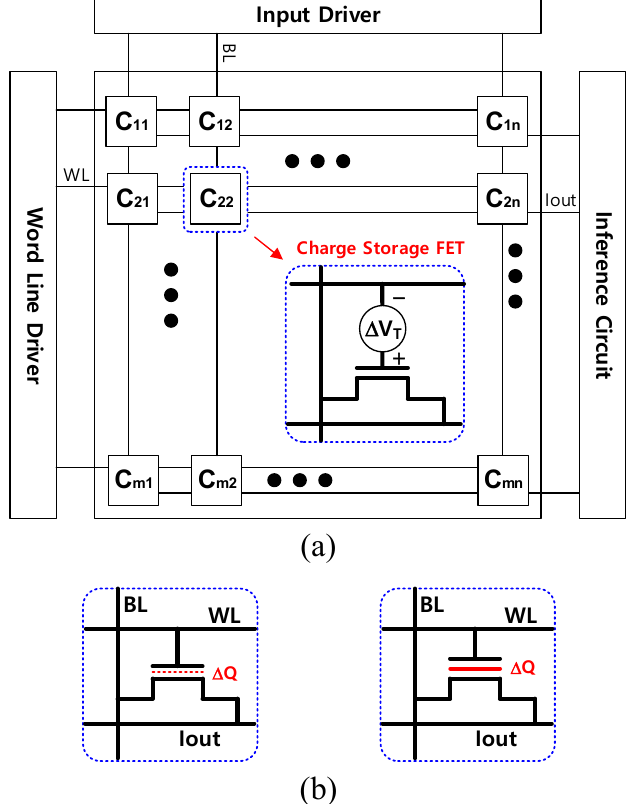
Figure 2. ( a ) Architecture of the VMM using a charge storage FET cell and ( b ) cell examples.